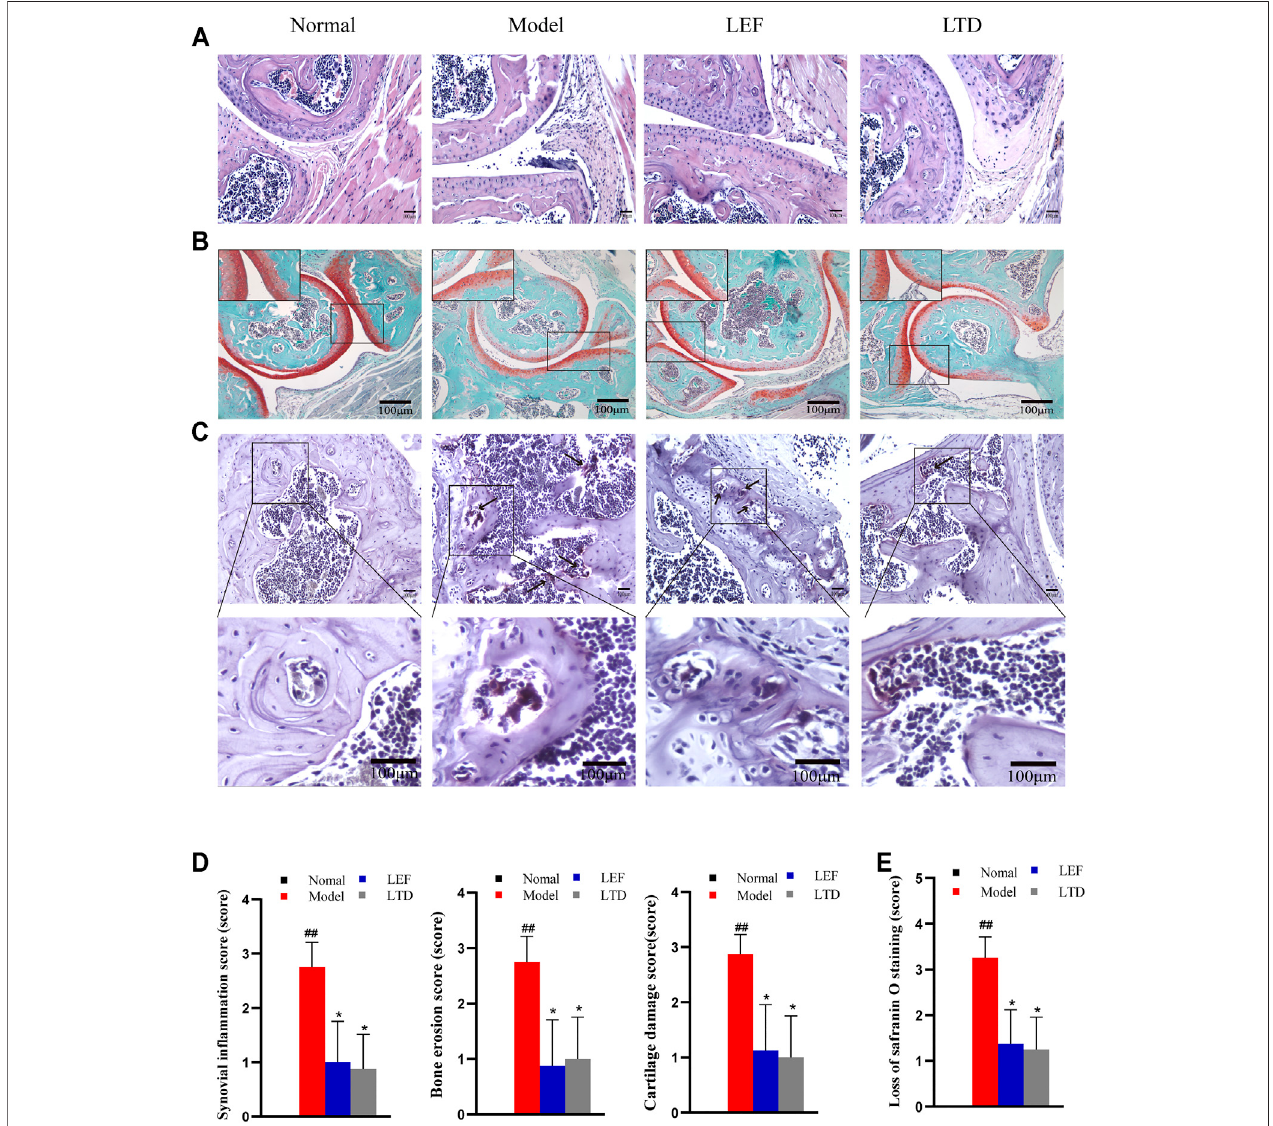
FIGURE 3 | LTD improved histopathological in fl ammation in CIA mice. (A) HE staining of synovial tissue of joint (magni fi cation × 200). (B) Saffron O staining of articular tissue (magni fi cation × 100). (C) TRAP staining of articular tissue (magni fi cation × 200). The arrow points to osteoclasts. (D) Synovial in fl ammation score, bone erosionscore,andcartilagedamagescore. (E) LossofsaffronOstainingscore.Alldataareshownasmeans ± S.D.( n (cid:1) 8);## p < 0.01,comparedwiththenormalgroup; * p < 0.05 ** p < 0.01, compared with the model group. The scale bar corresponds to 100 µm throughout.